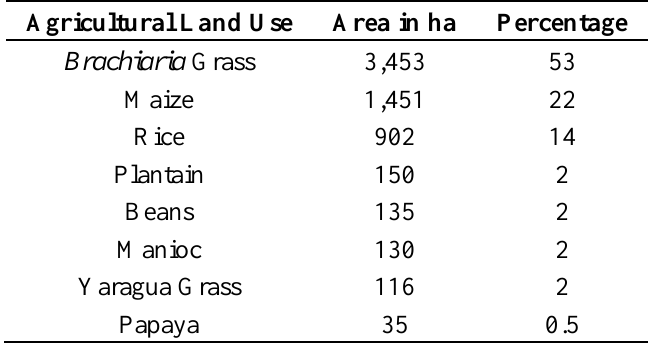
Table 1. Agricultural Crop Production with Pasture for Livestock Forage in 2009 for the Province of Tahuamanu, Madre de Dios, Peru (Source: Adapted from [50]). Agricultural Land Use Area in ha Percentage Brachiaria